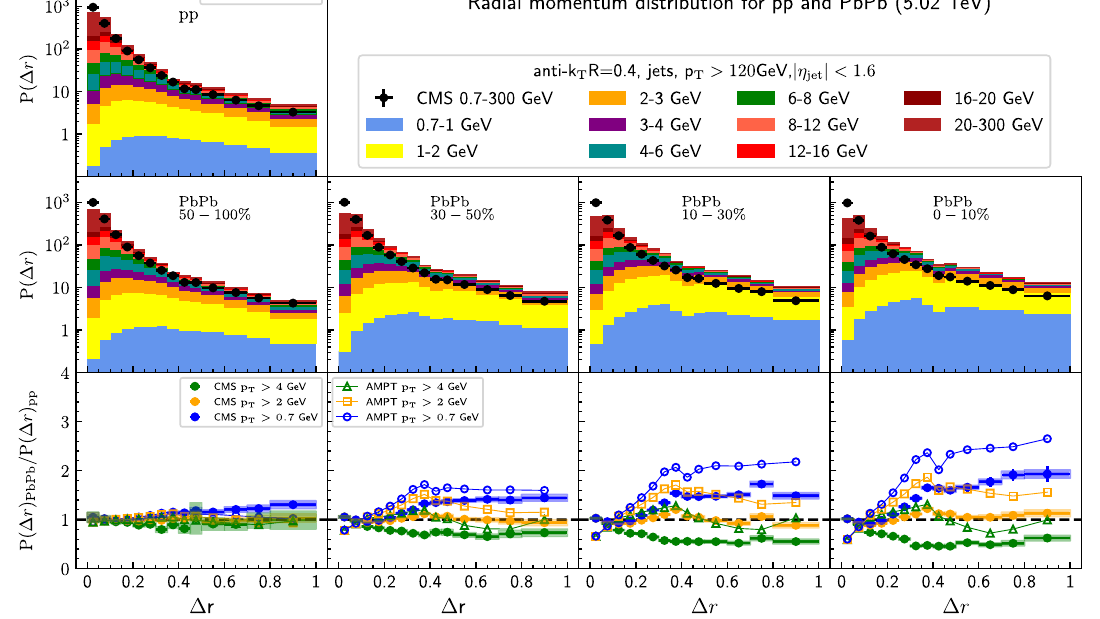
> 120 sent the contributions from different p T intervals for charged particles. T The accumulated histogram is for 0 . 7 < p T < 300 GeV. The bottom panels show the ratio between Pb + Pb and p + p collisions for different p T intervals, 4 − 300 GeV, 2 − 300 GeV and 0 . 7 − 300 GeV. The data are taken from CMS [66]